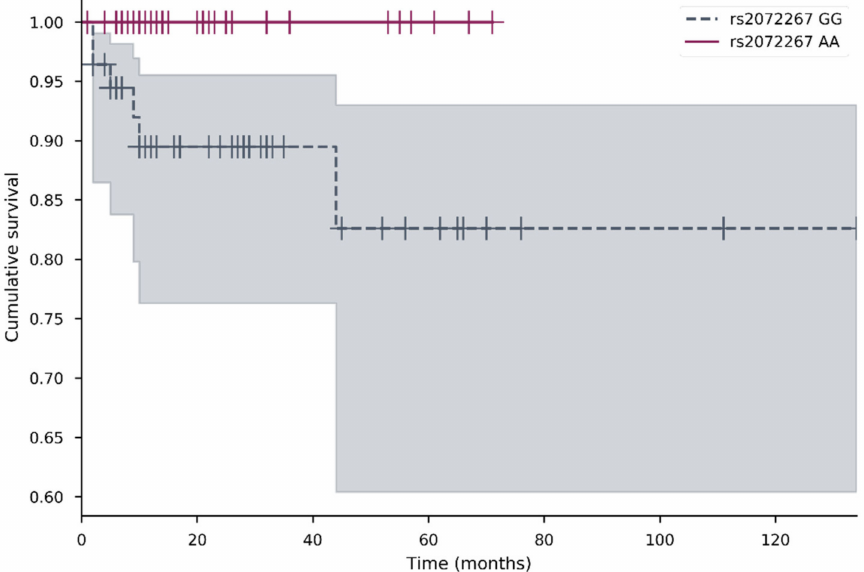
Figure 2. Metastasis-free survival of patients with POLG rs2072267 AA and GG genotypes. Kaplan– Meier survival curves for MFS comparing different POLG rs2072267 AA and GG genotypes ( p = 0.032) in the cervical cancer cohort. Censored cases are indicated as a vertical line. The different color represents different genotype; the shadow of the same color represents 95% confidence